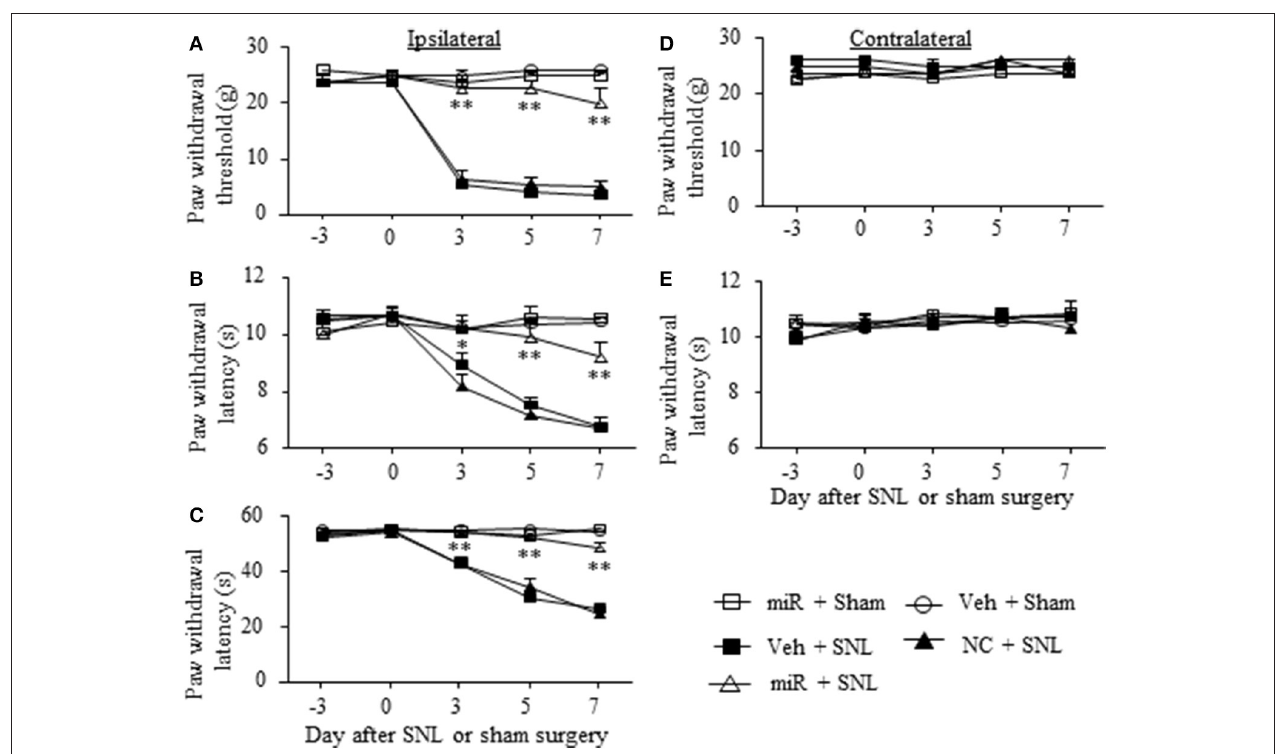
FIGURE 4 | Rescuing DRG miR-143 expression impaired neuropathic pain. miR, microRNA; NC, negative control; SNL, spinal nerve ligation; Veh, vehicle; Microinjection of miR-143 mimics, but not negative control, into the ipsilateral L5 DRG significantly attenuated SNL-induced decreases in paw withdrawal threshold in response to mechanical stimulation (A), in paw withdrawal latency in response to thermal stimulation (B) and in paw withdrawal jump latency in response to cold stimulation (C) on the ipsilateral side on days 3, 5, and 7 after SNL. Neither miR-143 mimics nor negative control altered paw responses to mechanical (D) and thermal (E) stimuli on the contralateral side. No changes in paw responses were seen on either ipsilateral or contralateral side in sham rats microinjected with vehicle or miR-143 mimics. n = 5 rats/group. Two-way ANOVA followed by Tukey post-hoc test. * P < 0.05 or ** P < 0.01 vs. the vehicle plus SNL group at the corresponding time